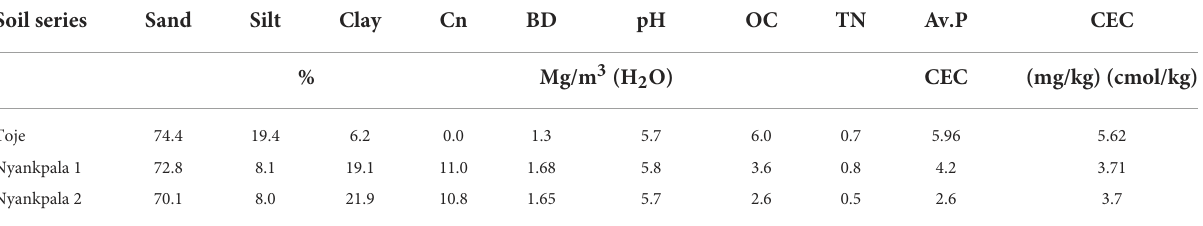
TABLE 1 Some physicochemical properties of the soils * . Soil series